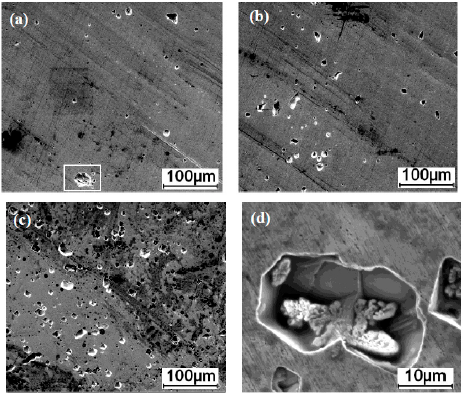
Figure 9. Corrosion pitting morphologies of samples: ( a ) BM; ( b ) J P ; ( c ) J P-T ; and ( d ) high-magnification image of BM.